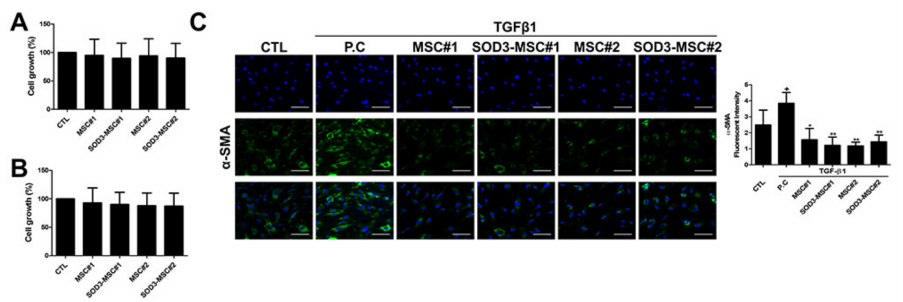
Figure 4. The regenerative and wound-healing potential of MSCs. ( A , B ) E ff ects of SOD3-MSCs on human dermal fibroblast (HDF) and HaCaT proliferation in transwell co-culture system were examined by CCK-8 assay. ( C ) Representative images of α -SMA expression. HDF was cultured with 10 ng / mL TGF- β for 48 h in the absence or presence of MSCs and α -SMA (green) was detected by immunofluorescence. α -SMA level was quantified by Image J. Scale bar = 100 µ m. Results are shown as mean ± SD. * and ** represent p < 0.05 and p < 0.01, respectively. p -value significance was calculated by comparing other groups against the ( + ) group (marked as + ).